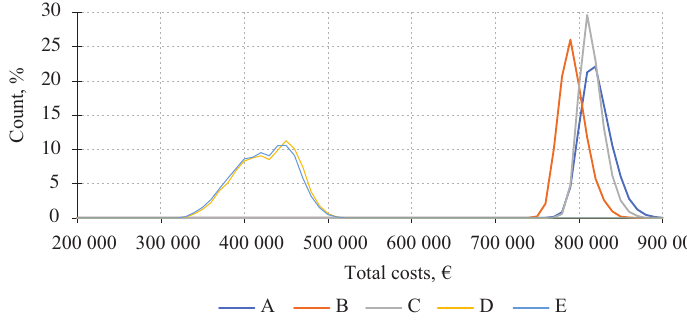
Figure 4. The probability distribution of costs for each alternative